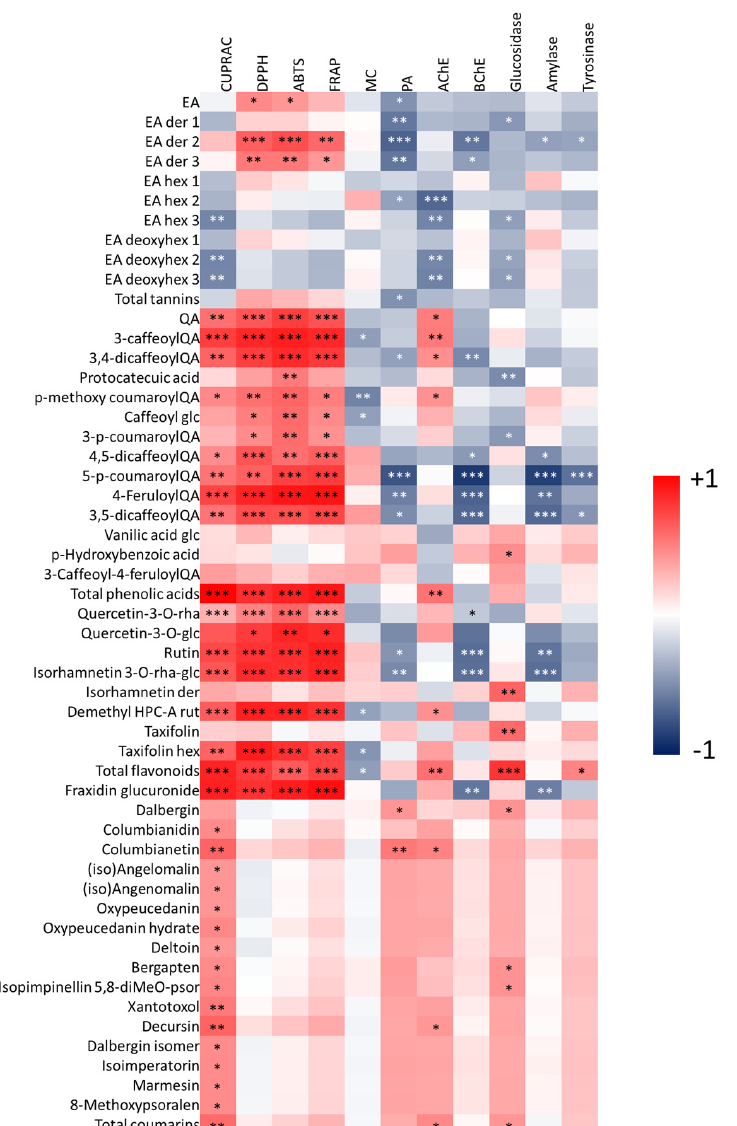
Figure 5. Correlation heatmap showing positive (red color) and negative (blue color) correlations (-1 < Pearson’s r < 1) between Sartoria phytoconstituents and biological activities. Der: derivative; EA, ellagic acid; diMeO: di methoxy-; hex, hexoside; HPC-A, hedysarimpterocarpene-A; MC, metal chelating activity; PA: phosphomolybdenum; psor: psoralene; QA, quinic; rha, rhamnoside; rut, rutinoside. *: p -value < 0.05; **: p -value < 0.01; ***: p -value < 0.00.